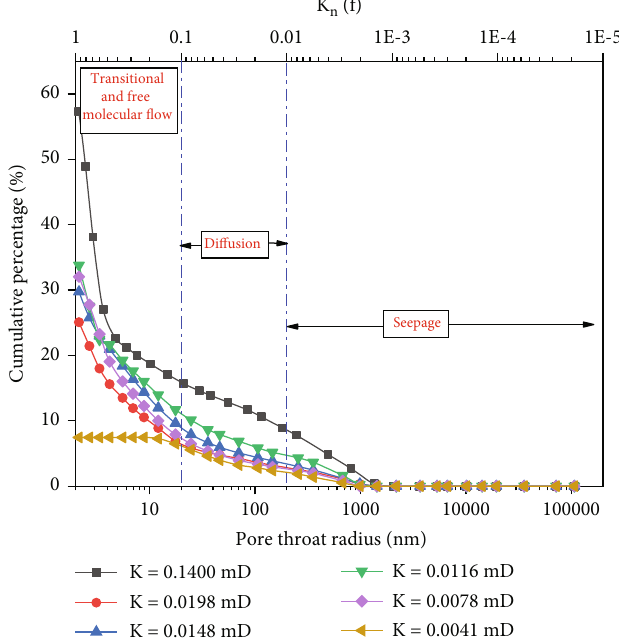
Figure 1: Cumulative distribution curve of pore throat radius.